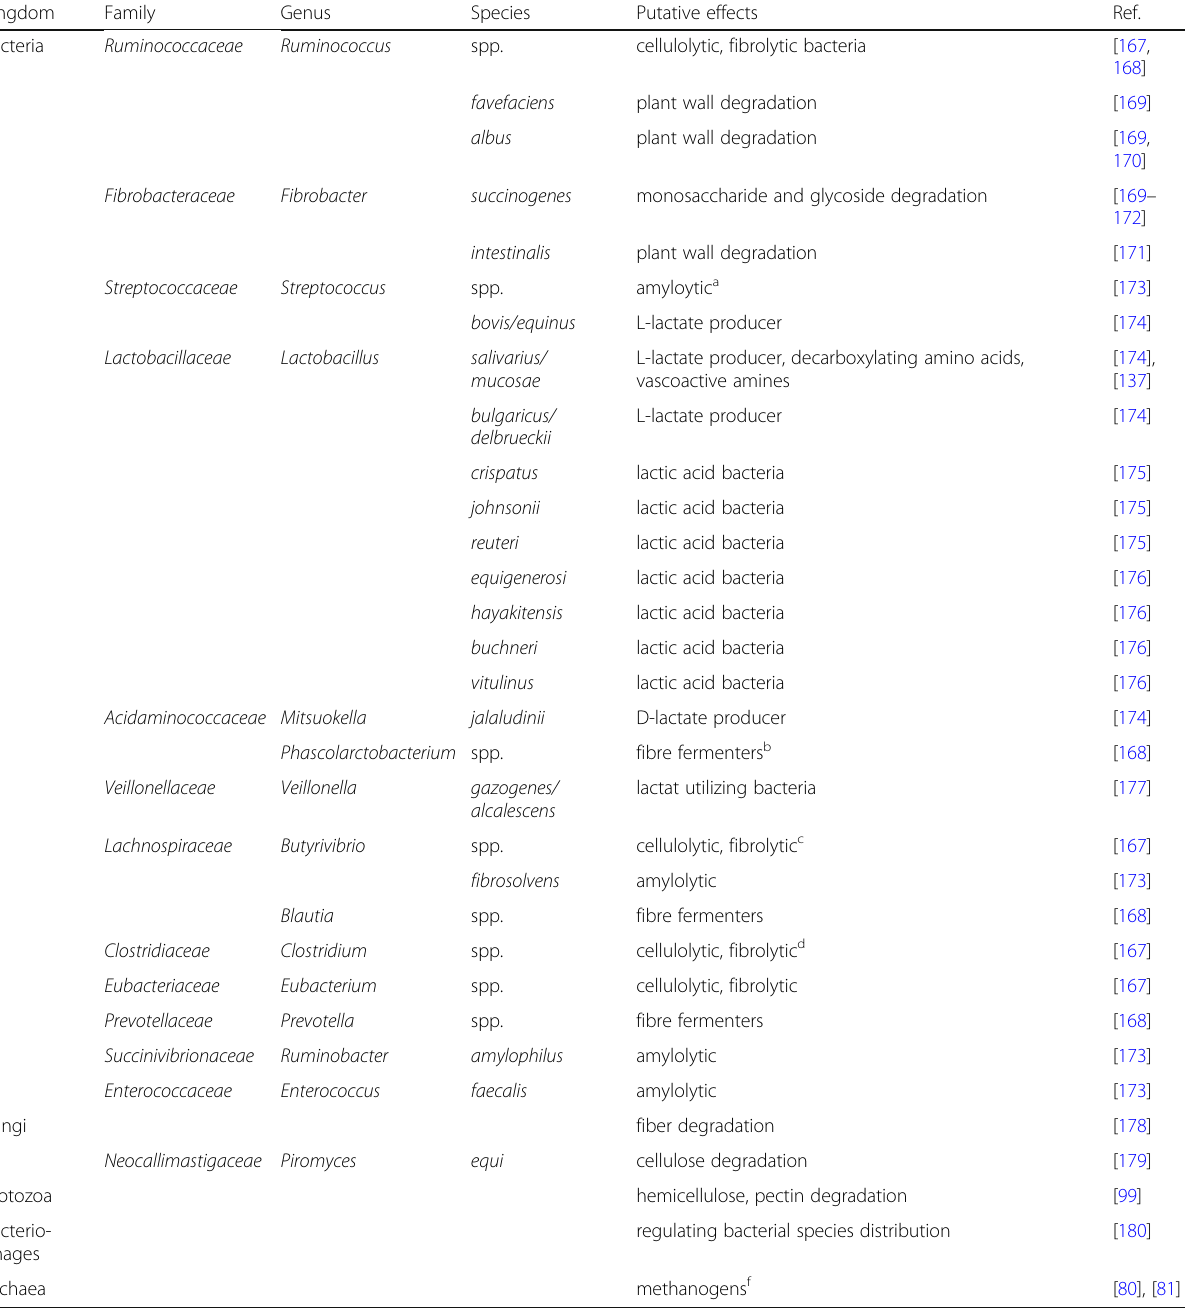
Table 1 Microorganisms with nourishment-associated activity in the gastro enteral tract of horses